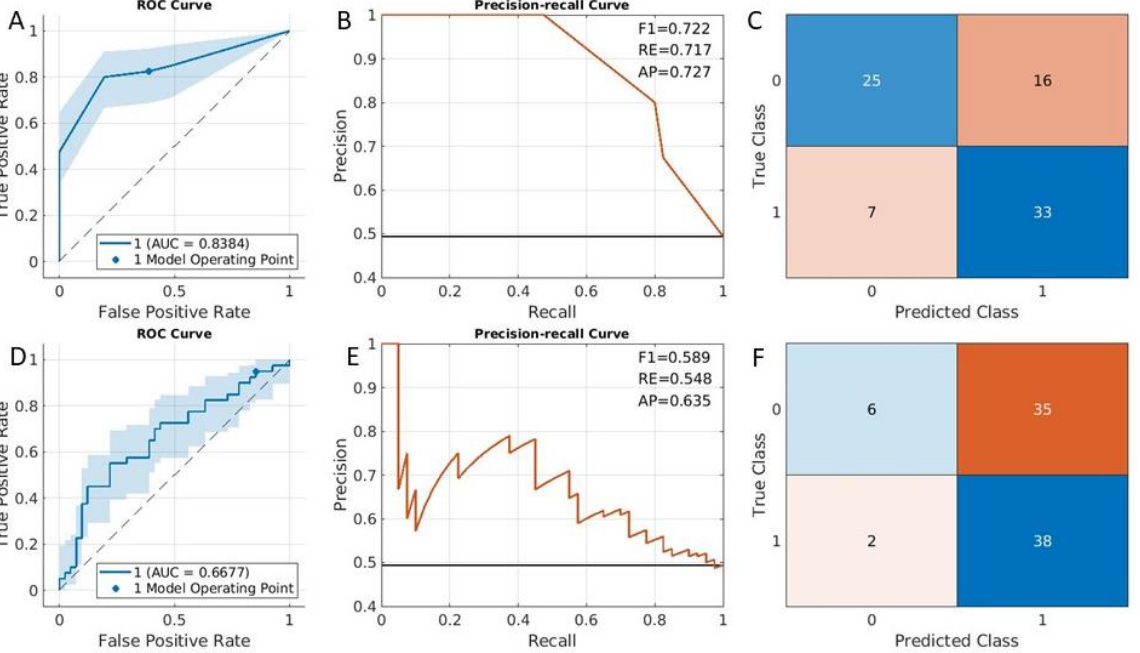
Figure 4. Clinical risk category classification results from testing dataset. ROC curve ( A ), precision – recall curve ( B ) and confusion matrix ( C ) were computed from an ensemble method. ROC curve ( D ), precision – recall curve ( E ), and confusion matrix ( F ) were obtained from LASSO method.